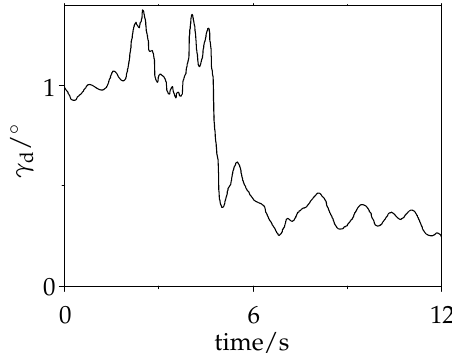
Figure 6. Simulation result for the orientation control